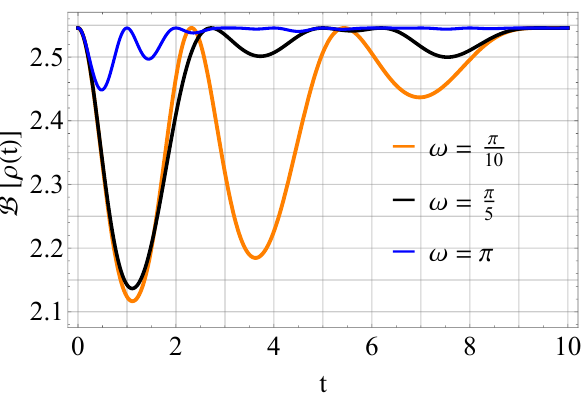
Figure 5. B [ ρ ( t )] for three values of ω . The other parameters are r = 0.9, b = 0.5, and ∆ =